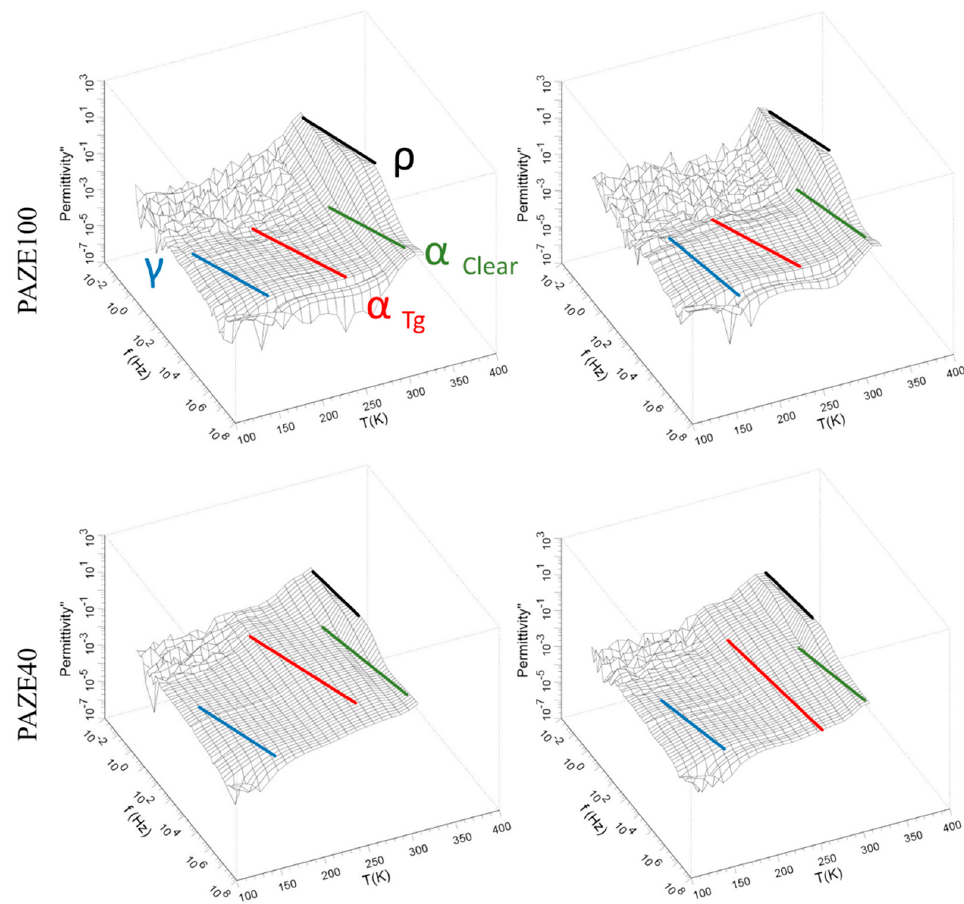
Figure 8. 3D plots of imaginary part of dielectric permittivity ε ” of the unoriented ( left ) and oriented (right) PAZE100 and PAZE40.